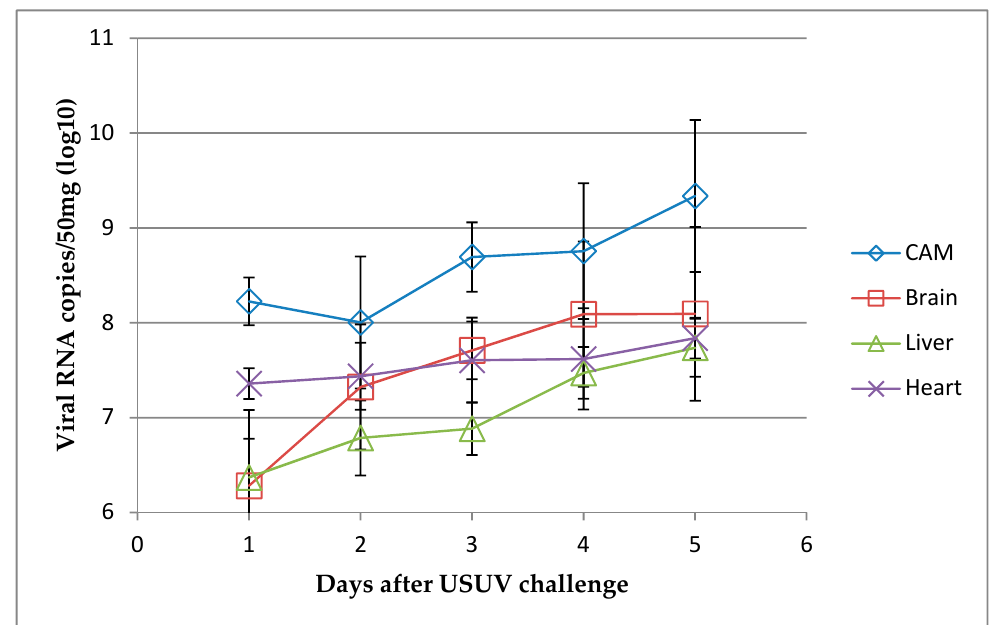
Figure 7. Usutu virus RNA loads detected by RT-qPCR in the brain, heart, liver, and chorioallantoic membrane (CAM) samples of chicken embryos inoculated with USU-BE-Seraing/2017 strain (10 5 TCID 50 ) via the allantoic route. The data show the mean log 10 viral RNA copies/mL ± standard deviation. n = 5 per tissue per day of infection.